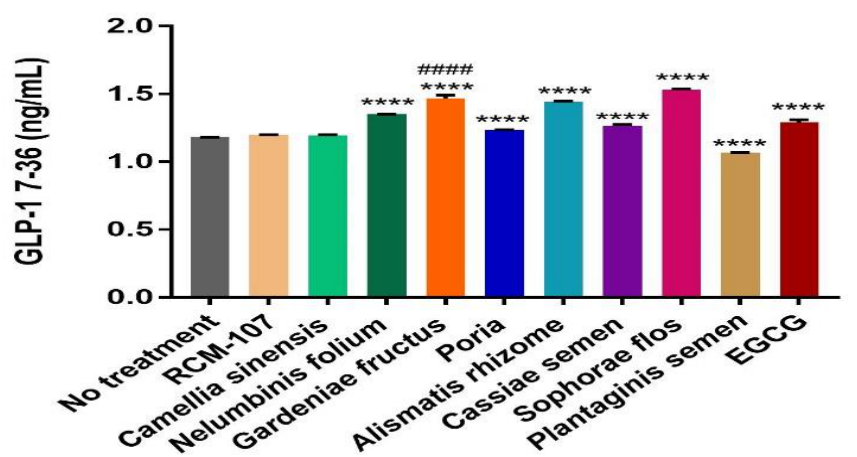
Figure 2. Effects of RCM107, its eight ingredients and EGCG on glucagon-like peptide-1 (GLP-1) release from the NCl-H716 cells. The maximal concentrations used for ELISA were selected from the highest concentration that maintained cell viability above 96% (0.01 mg / mL of RCM-107, Camellia sinensis, Gardeniae fructus and EGCG; 0.05 mg / mL of Nelumbinis folium; 0.1 mg / mL of Sophorae flos; 0.5 mg / mL of Plantaginis semen; 0.8 mg / mL of Poria and Cassiae semen; and 1 mg / mL Alismatis rhizome were used). Cells were incubated for 2 h with test samples and the active GLP-1 contents were normalized and expressed as ng / mL. Values are means ± SD of three replicate experiments. **** p < 0.0001 vs cells with no treatments; #### p < 0.0001 vs the positive control EGCG.